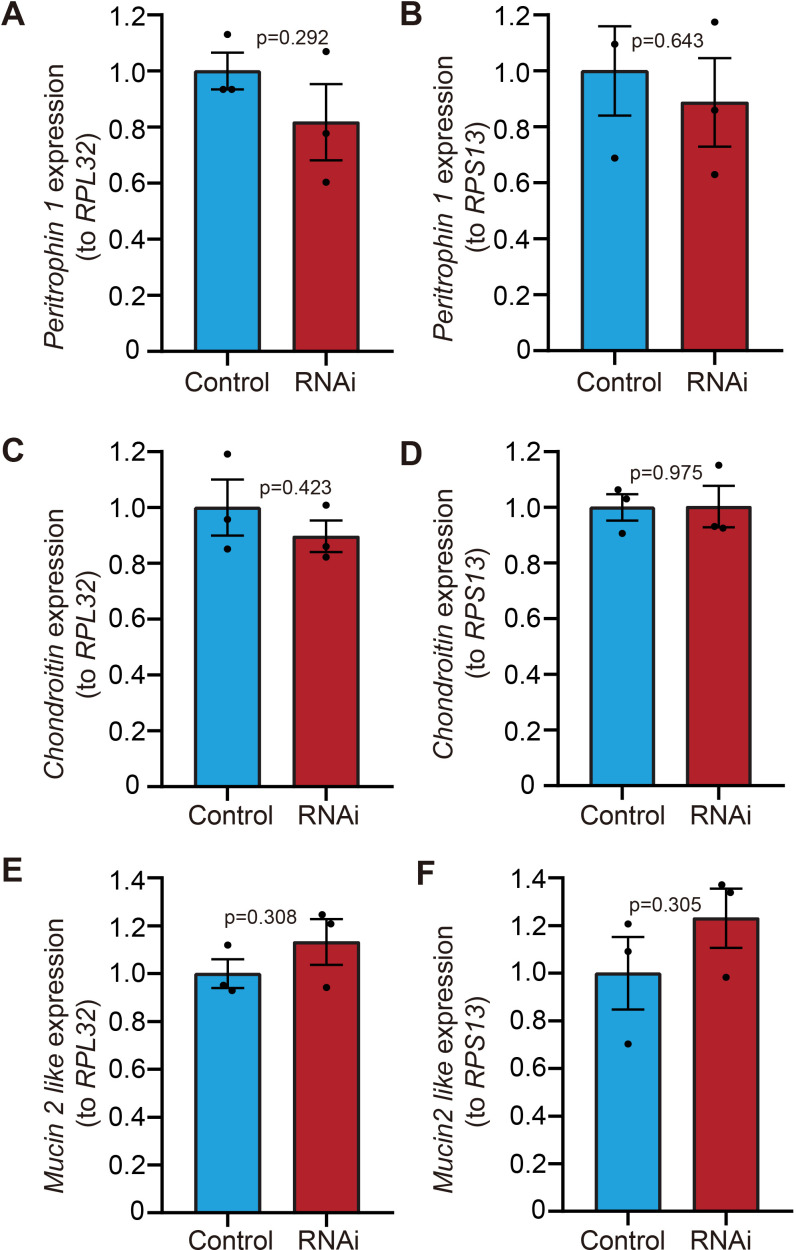
The expression of three PxMucin homologs is not significantly influenced by the double-stranded RNA (dsRNA) treatment.(A, B) Peritrophin 1 like. (C, D) Chondroitin. (E, F) Mucin 2 like. RPL32 and RPS13 were used as internal control Fu et al., 2013 for qRT-PCR. Error bars represent the standard error of three biological replicates. p values of statistical tests are shown in figures (two-tailed unpaired t-test).
Figure 4—figure supplement 2—source data 1.The expression of three PxMucin homologs is not significantly influenced by the double-stranded RNA (dsRNA) treatment.